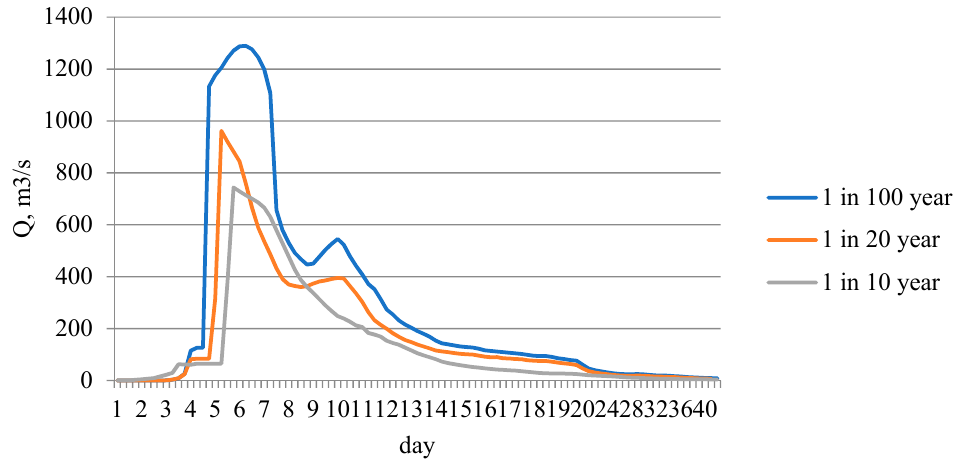
Figure 4. Hydrographs of water release from the Astana Reservoir during floods of 10-, 20- and 100-year return period.